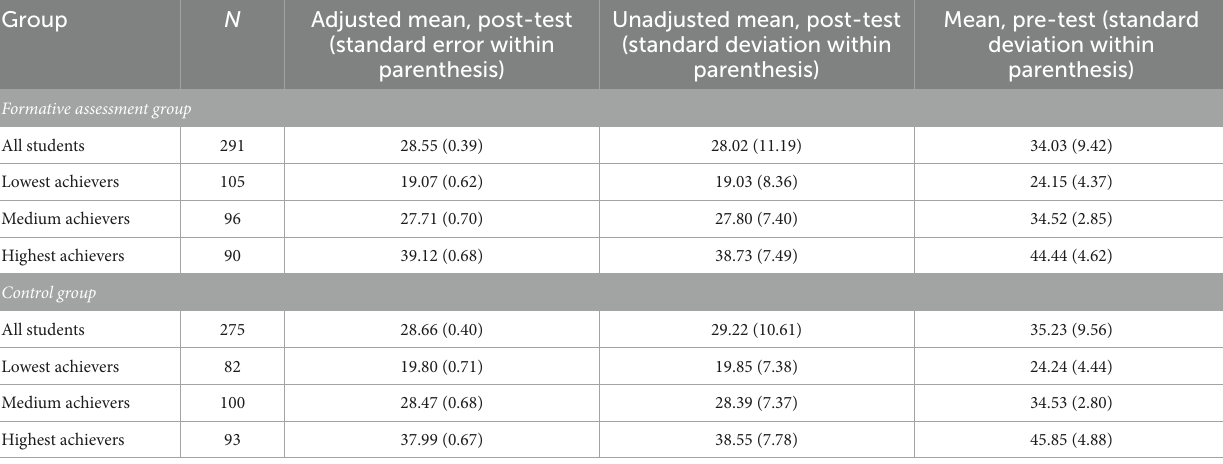
TABLE 1 Mean scores on the